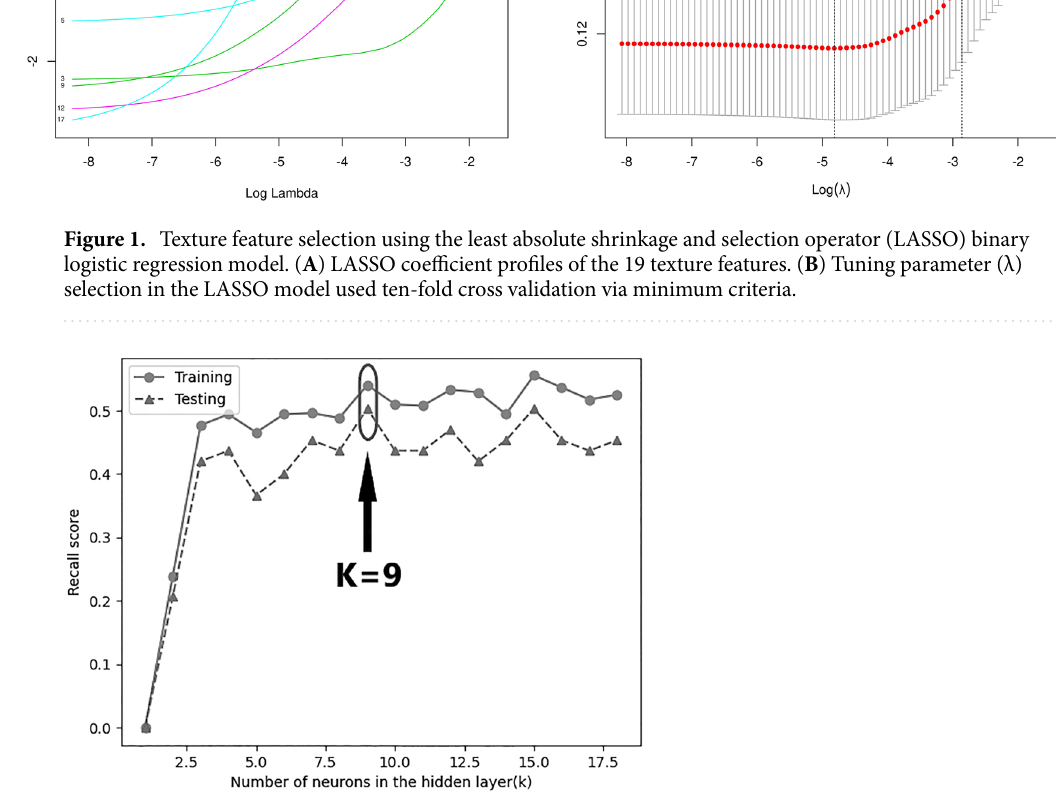
Figure 2. Change of recall score along with increasing numbers of hidden layer. When the number of neurons in the hidden layer reached 9, the recall score in 10 cross validation groups was the highest as the model performance remained